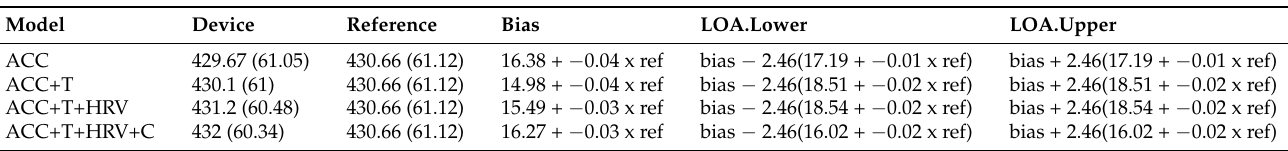
Table 1. Bias and limits of agreement for total sleep time (TST), 2-stage classification, and the four models analyzed in this paper.